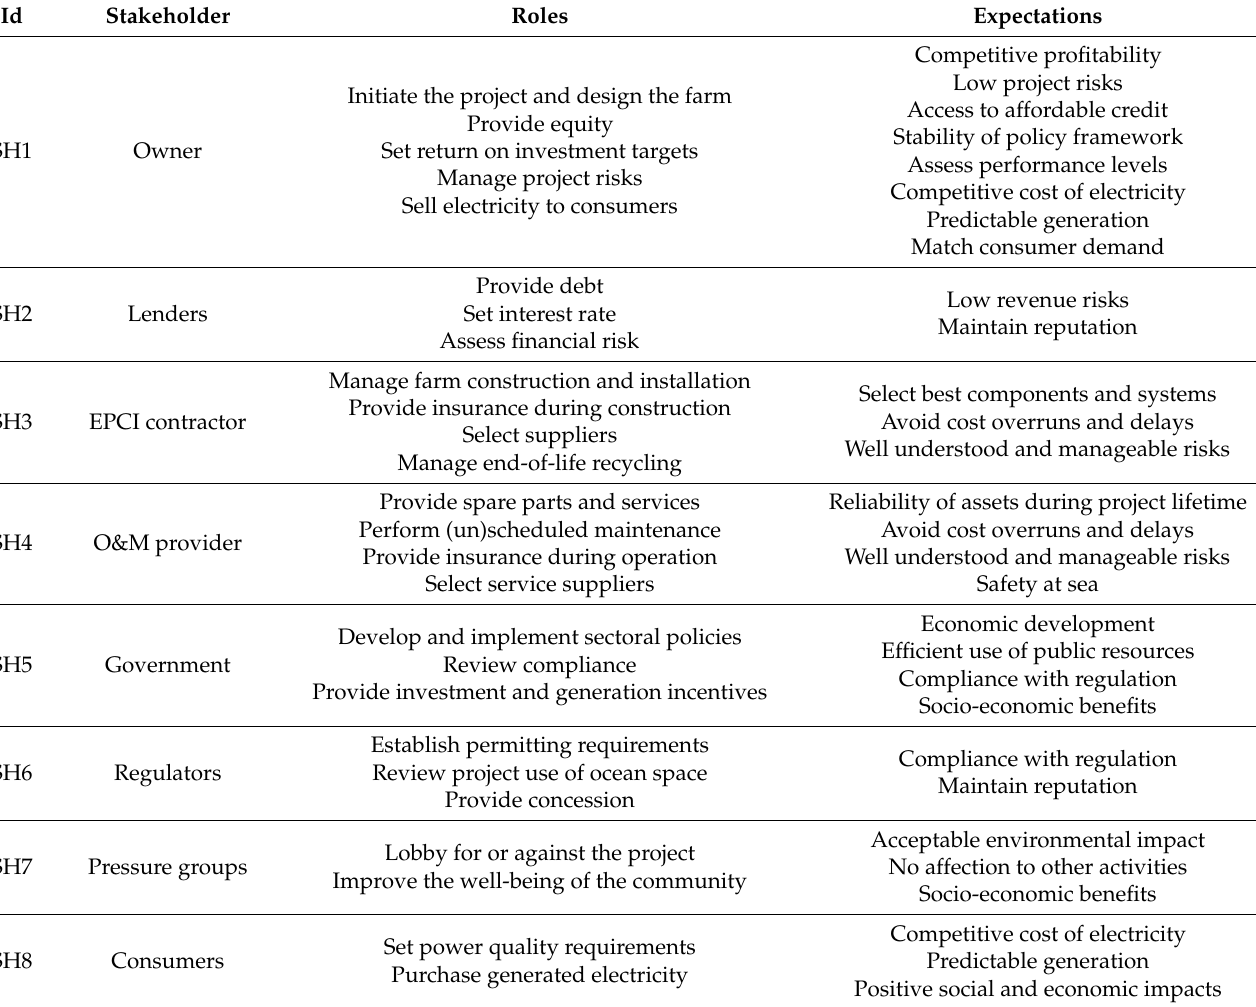
Table 6. Stakeholder roles and expectations.